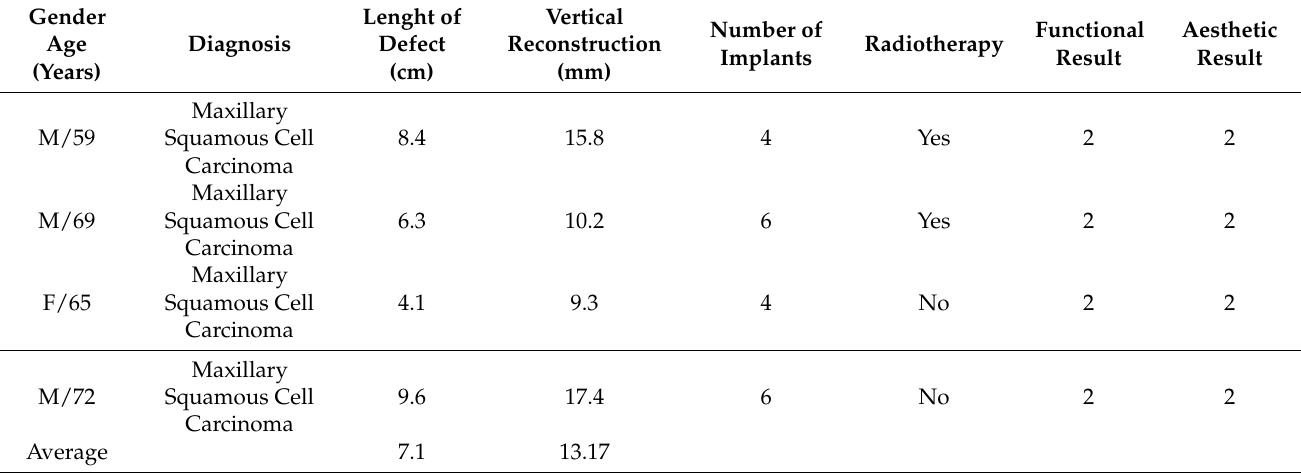
Table 1. Descriptive variables in all